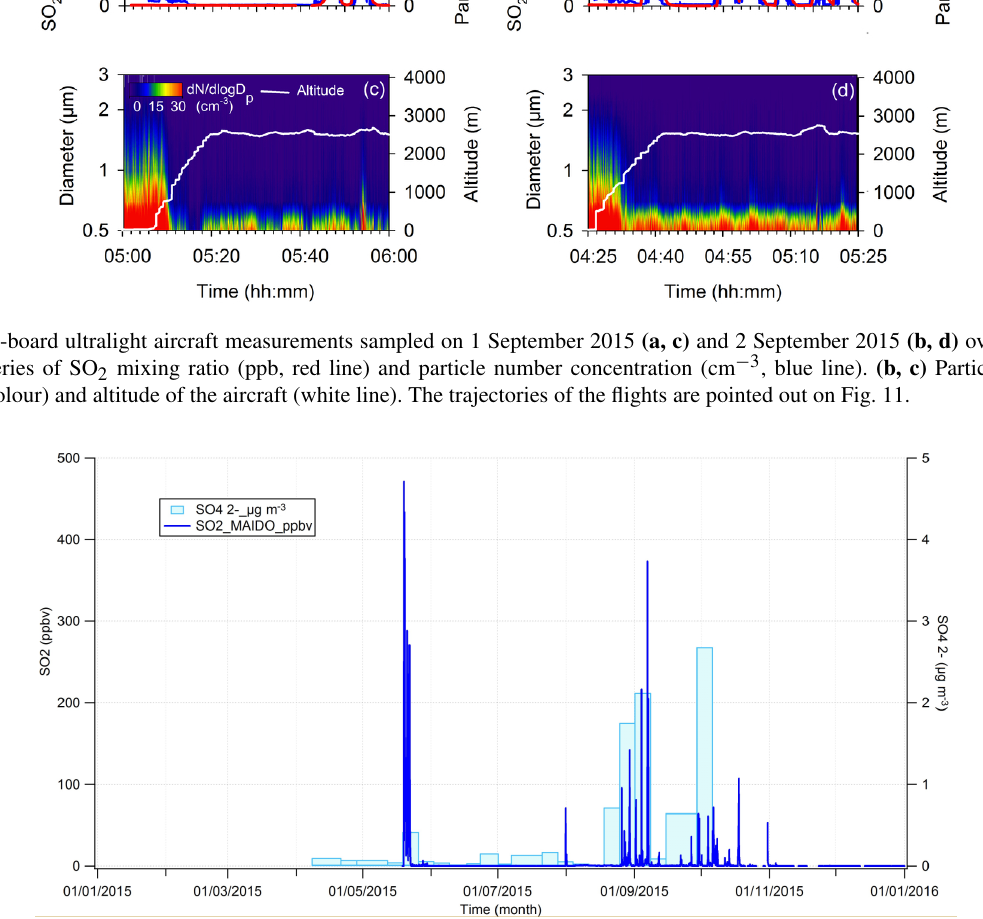
Figure 13. Time series of the SO 2 mixing ratio (ppb) measured at the Maïdo observatory in the year 2015. Measurements started on 19 May. Time series of SO 2 − concentration (µgm − 3 ) from filter sampled at the Maïdo observatory integrated each week at night (between 18:00 and 4